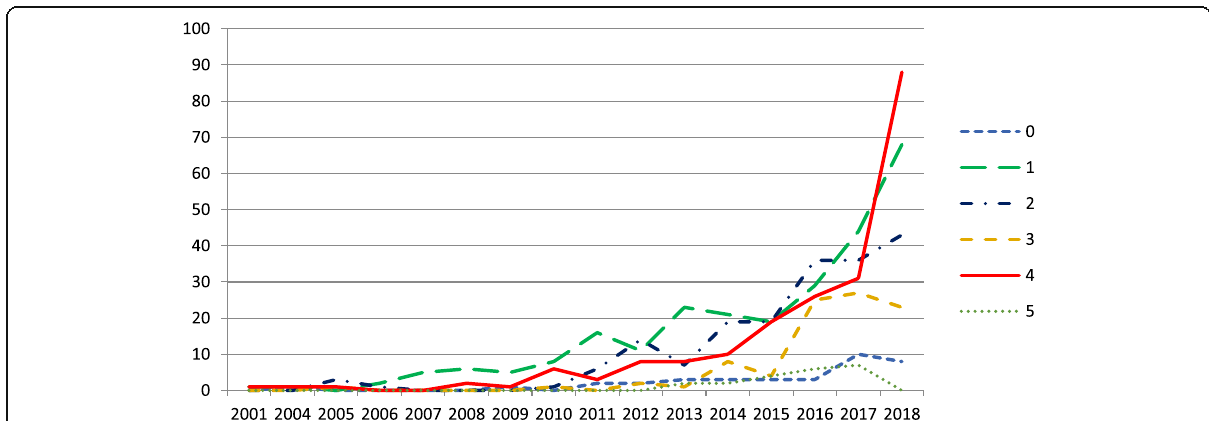
Fig. 5 STEM education publication distribution across different journal categories over the years. (Note: 0=subject-0; 1=subject-1; 2=subject-2; 3= subject-3; 4=subject-4;